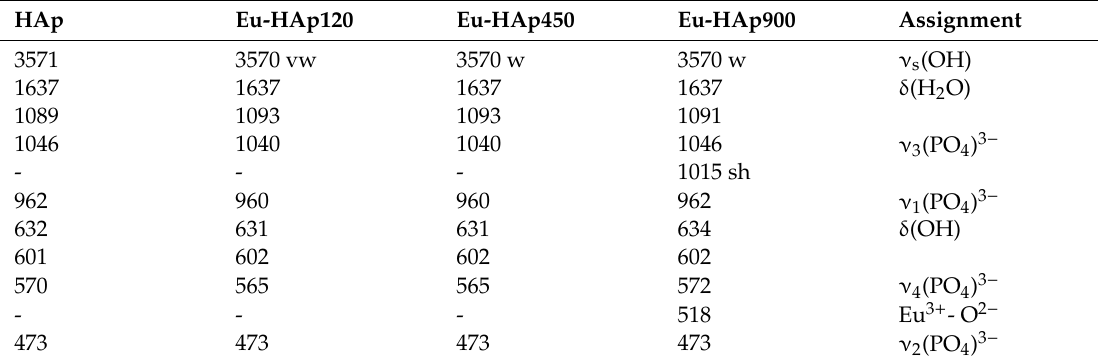
Table 6. Measured absorption in the FTIR spectra and relative assignments for HAp samples. Vw = very weak, w = weak, sh = shoulder. HAp Eu-HAp120 Eu-HAp450 Eu-HAp900 Assignment